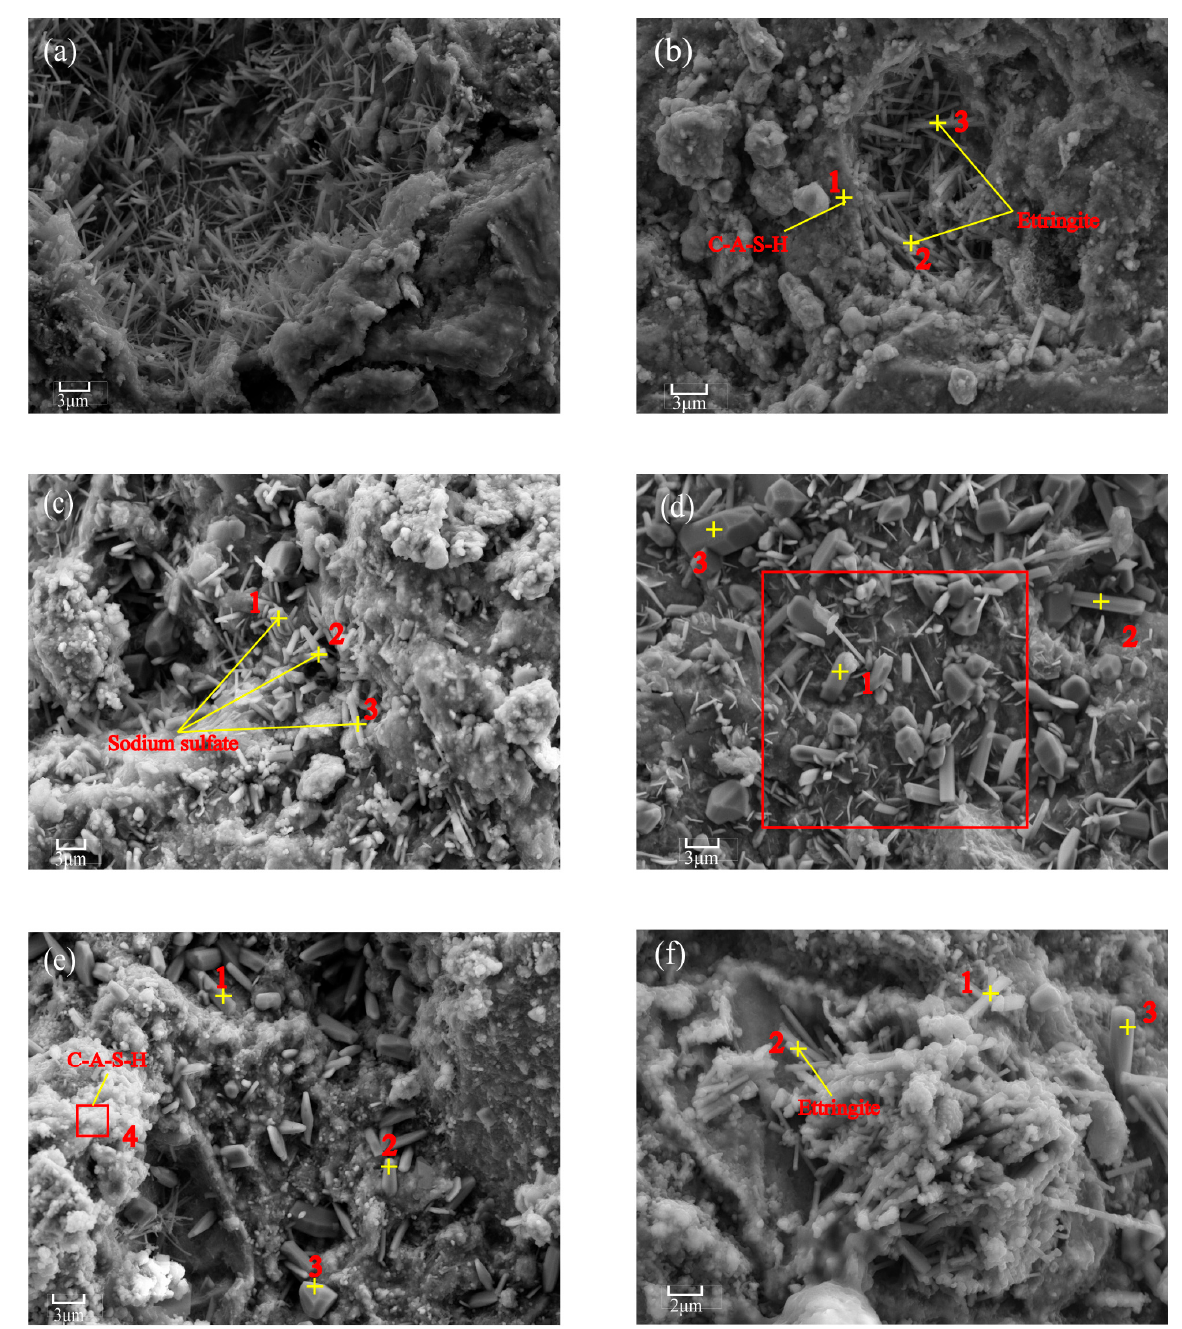
Figure 4. SEM-EDS result for ( a ) B-3d; ( b ) B-28 d; ( c ) B(V)-3 d; ( d ) B(V)-28 d; ( e ) B(III)-3 d; ( f ) B(III)-28 d.